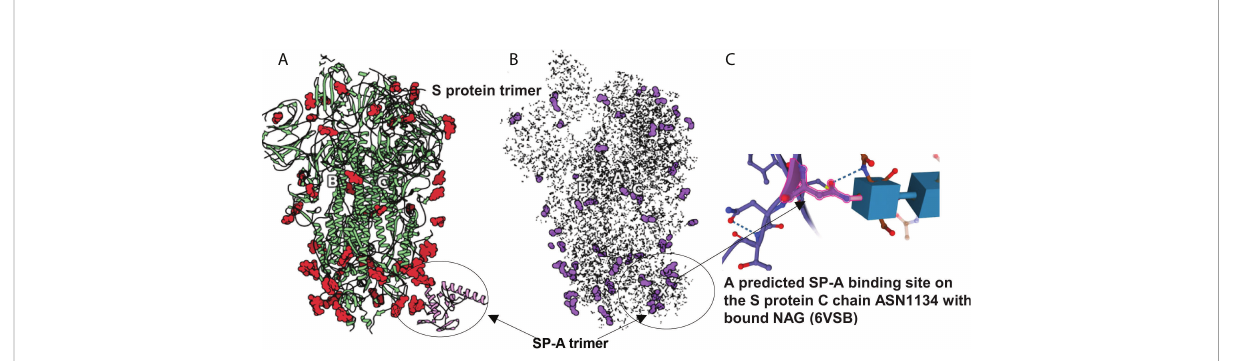
FIGURE 3 SARS-CoV-2 S protein (6VSB) modeling. (A) : The S protein trimer model (green ribbons representing chains A, B and C with red denoting glycan residues) and bound SP-A (pink). (B) : The fi nal reduced S-protein-SP-A complex processed by our QAOA-based MaxCut protein pruning tool followed by ZDOCK docking (purple representing glycan residues and X marking the SP-A binding site. (A, B) were derived from the visualization software SAMSON. (C) : The amino acid ASN 1134 on the S protein C chain is identi fi ed as a likely candidate to mediate SP-A binding. ASN 1134 is outlined by dark pink and the blue cubes represent NAG